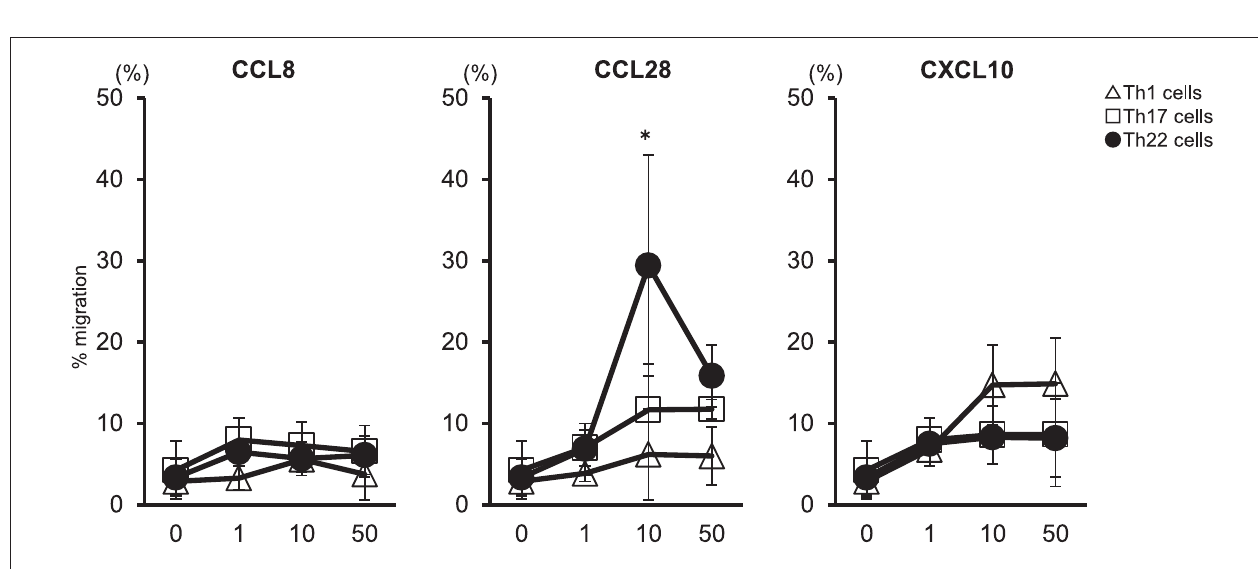
FIGURE 3 | cells (IFN- γ + CD4 + ), Th17 cells (IL-17 + CD4 + ), and Th22 cells (IFN- γ − IL-17 − IL-22 + CD4 + ) in synovial tissue from RA patients exhibiting low degrees of disease activity (LDA-RA), high degrees of disease activity (HDA-RA), or OA. Dual-labeling immunofluorescence staining was performed using anti-IFN- γ , anti- IL-17, anti-IL-22 (green), anti-CD4 antibody (red), and nuclei staining with DAPI (blue). Merged images are shown ( top ; magnification: 200 × ). The number of cells was counted. Each symbol represents one donor sample. Horizontal bar = mean; vertical bar = standard deviation. (C) Immunohistochemical analysis in sequenced slices of the synovial tissues from patients exhibiting LDA-RA, HDA-RA, or OA was performed using specific antibodies against CCL8, CCL17, CCL20, or CCL28. Sections were counterstained with hematoxylin (top; magnification: 200 × ). The number of cells was counted. Each symbol represents one donor sample. Horizontal bar = mean; vertical bar = standard deviation. * p < 0.05 and ** p < 0.01 according to the Bonferroni method ( bottom ).